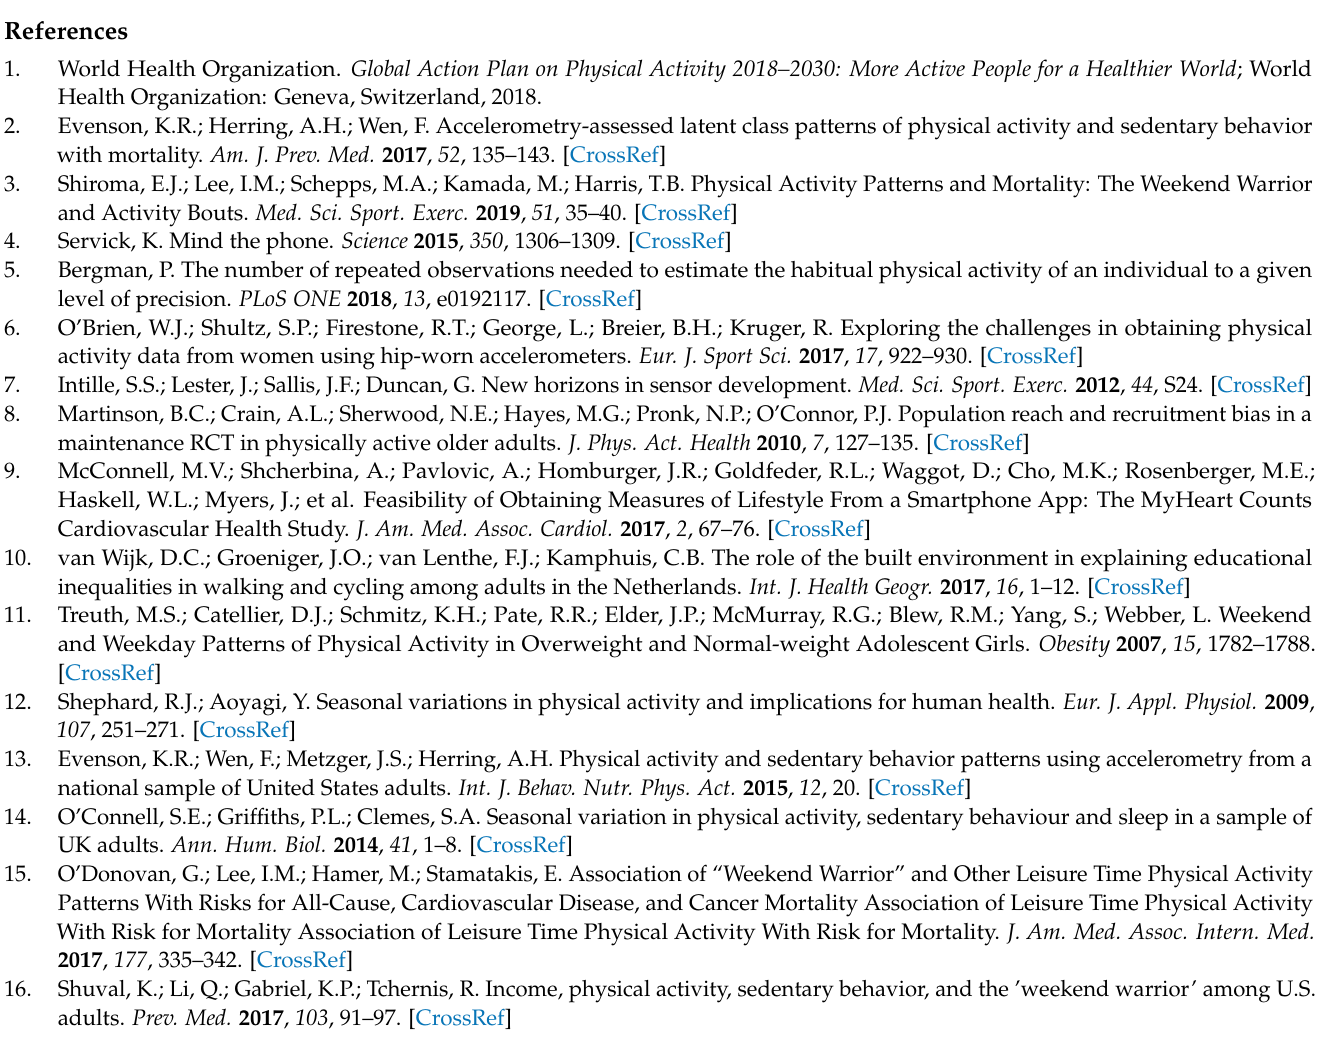
Figure A5. Activity duration by yearlong step count cluster, Inactive cluster disaggregated by step count data